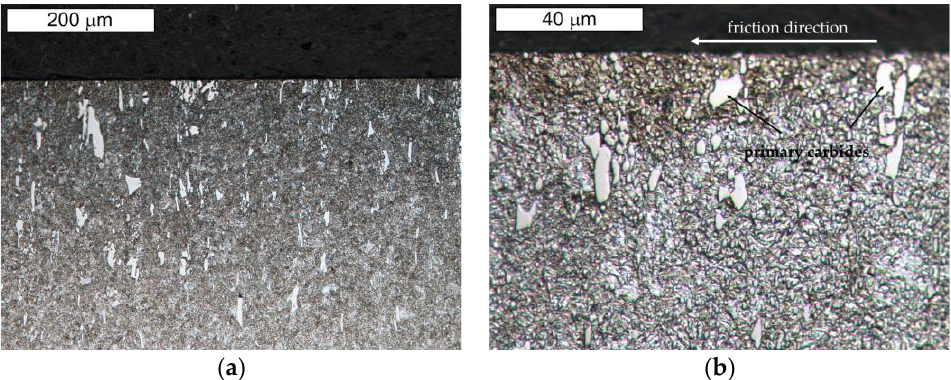
Figure 18. View of ( a ) the microstructure of steel NC11 in the surface area and ( b ) a magnified fragment of the area from Figure 18a. Light microscopy, etched.